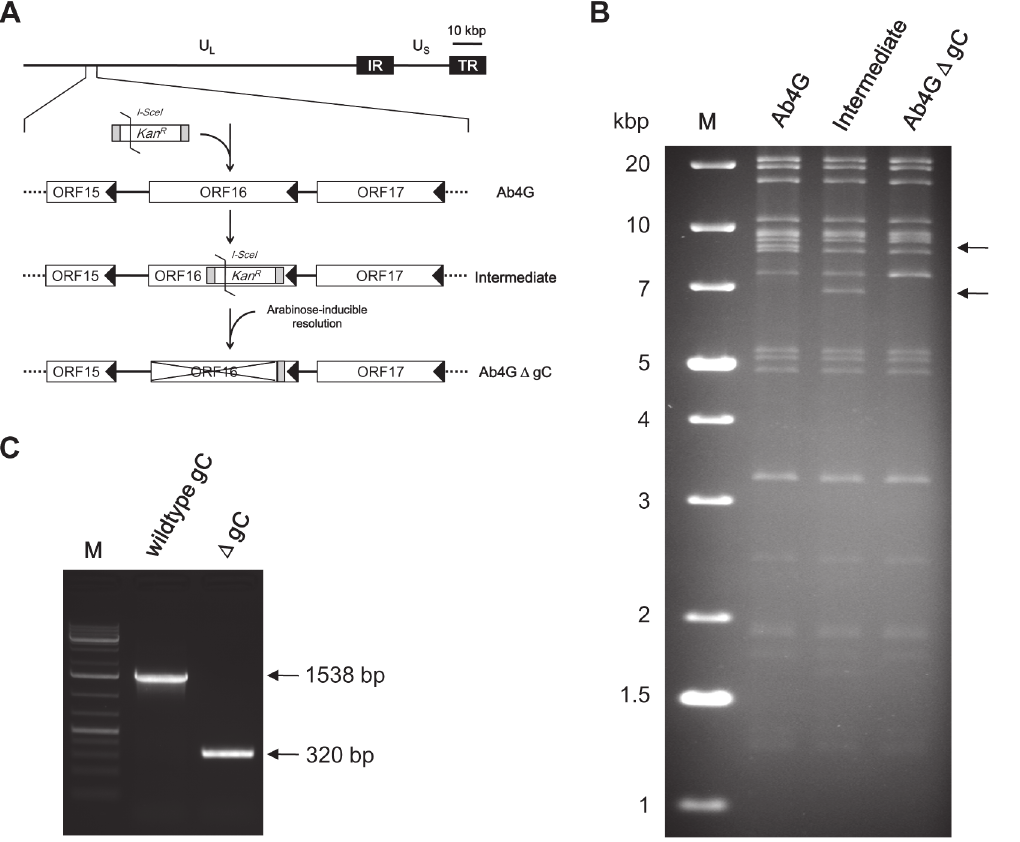
Fig 1. Construction and verification of a glycoprotein C (gC) deletion mutant of Ab4. A: An illustrative overview of generation of the deletion mutant in an infectious artificial bacterial chromosome (BAC) containing plaque purified Ab4 (Ab4). A PCR product that harbored the kan R gene instead of nucleotides 98 – 1315 of the ORF16 gene, which encodes gC, was electroporated into E . coli GS1783 for en passant (two-step) Red recombination. Intermediate colonies were screened and used for the second recombination step. Removal of Kan R was induced by 1% arabinose resulting in the final construct. B: Identity of the mutant (Ab4G Δ gC) was confirmed by restriction enzyme digests. BAC DNA from the parental, intermediate and final constructs was digested with HindIII and separated by 0.8% agarose gel electrophoresis. The intermediate construct harboring Kan R had an additional band of 6.8 kbp (lower arrow). After resolution, a fragment of 8.6 kbp (upper arrow) containing the ORF16 gene disappeared and a fragment of 7.4 kbp in the final mutant appeared. This apparent reduction is in line with the deletion introduced by mutagenesis. C: BAC DNA from Ab4 (wild-type) or Ab4G Δ gC was used as the template for PCR using gC primers that span the deleted region (forward: 5 ’ - CTCCGACCAGTGGAGTTATTAT-3 ’ ; reverse: 5 ’ - CTACTGTTTTTACCAGCGCTTC-3 ’ ). Bands of the predicted size were amplified in either case, thus confirming deletion of gC-encoding sequences in the mutant Ab4G Δ